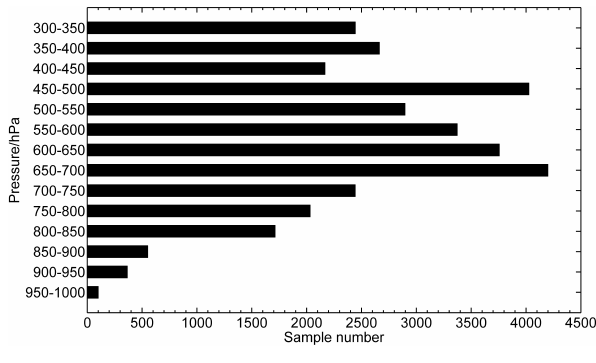
Figure 4. Vertical distribution characteristics of failed relative hu- midity observations from December 2008 to November